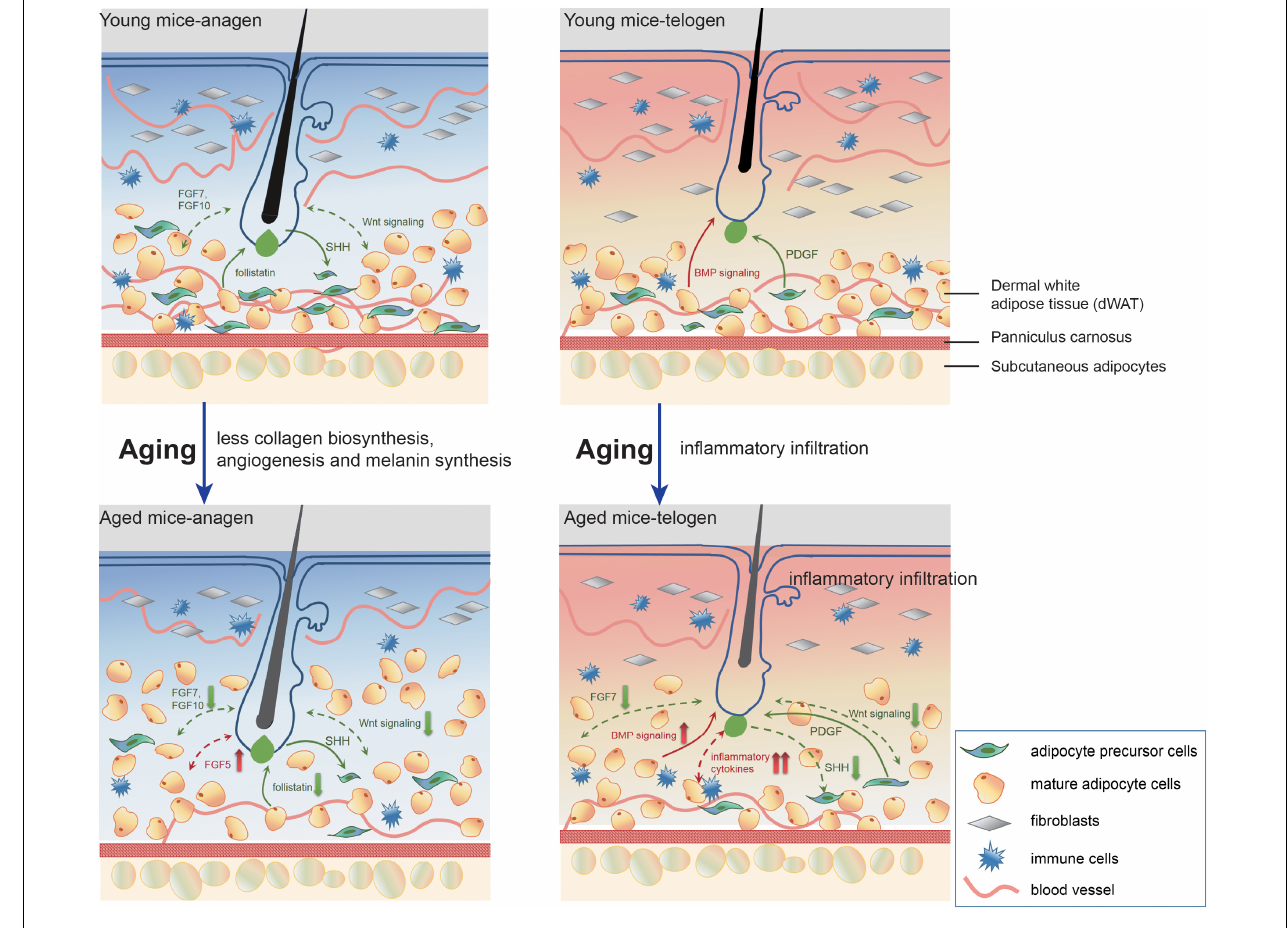
FIGURE 6 | A model of pathological interrelationship alterations between dWAT and HF with aging. With aging, dWAT undergoes structural remodeling: the thickness increases with the replenishment of other transformed adipogenic lineage cells (aging dermal fibroblasts) (Salzer et al., 2018). Meanwhile, during anagen, the impaired ability of paracrine signals secretion of aging cells in dWAT resulted in deficient collagen biosynthesis, angiogenesis, and melanin synthesis. Besides, crucial regulators for HF development also indicated abnormal expression: including follistatin (Chen et al., 2014), WNT signalings, and FGFs. During telogen, remarkably, aberrant inflammation recapitulated aging dWAT, which caused a serious bottleneck for HF cycling. Concomitantly, altered BMP, WNT signalings, and FGFs also underscored the emerging role of dWAT in aging HFs malfunction. The green arrows represent positive effects and the red one represents negative effects. The solid and dashed lines denote published results and our results